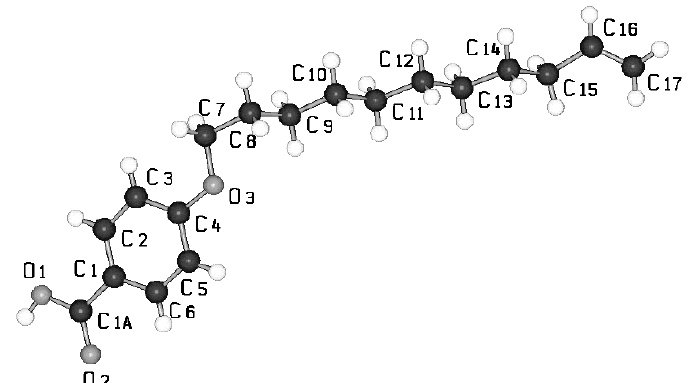
Figure 11. Representation of the conformation of a molecule of 4-(undec-10-enoxy)benzoic acid (UOBA) and numbering of the atoms. (A similar numbering scheme was used for the shorter 4-substituted benzoic